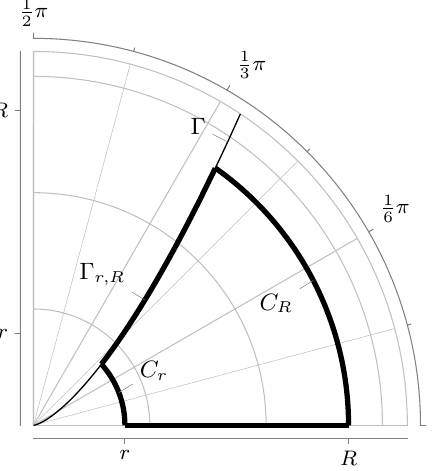
Figure 3. Auxiliary contour G r , R (heavy